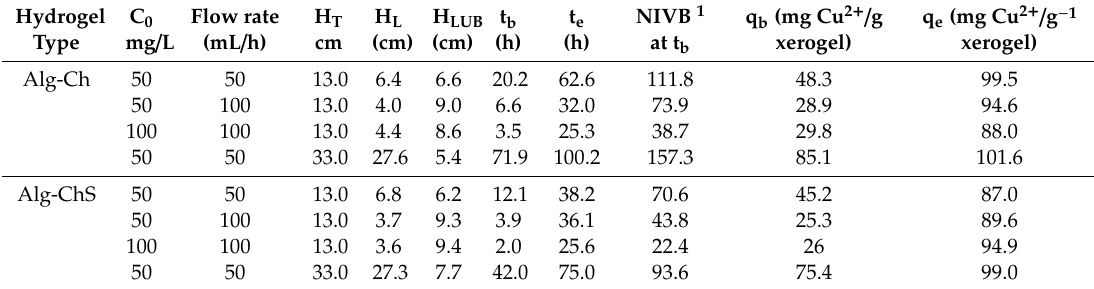
Table 3. Results obtained in the Cu(II) adsorption at pH 5.0 using fixed-bed columns filled with Alg-Ch or Alg-ChS hydrogel